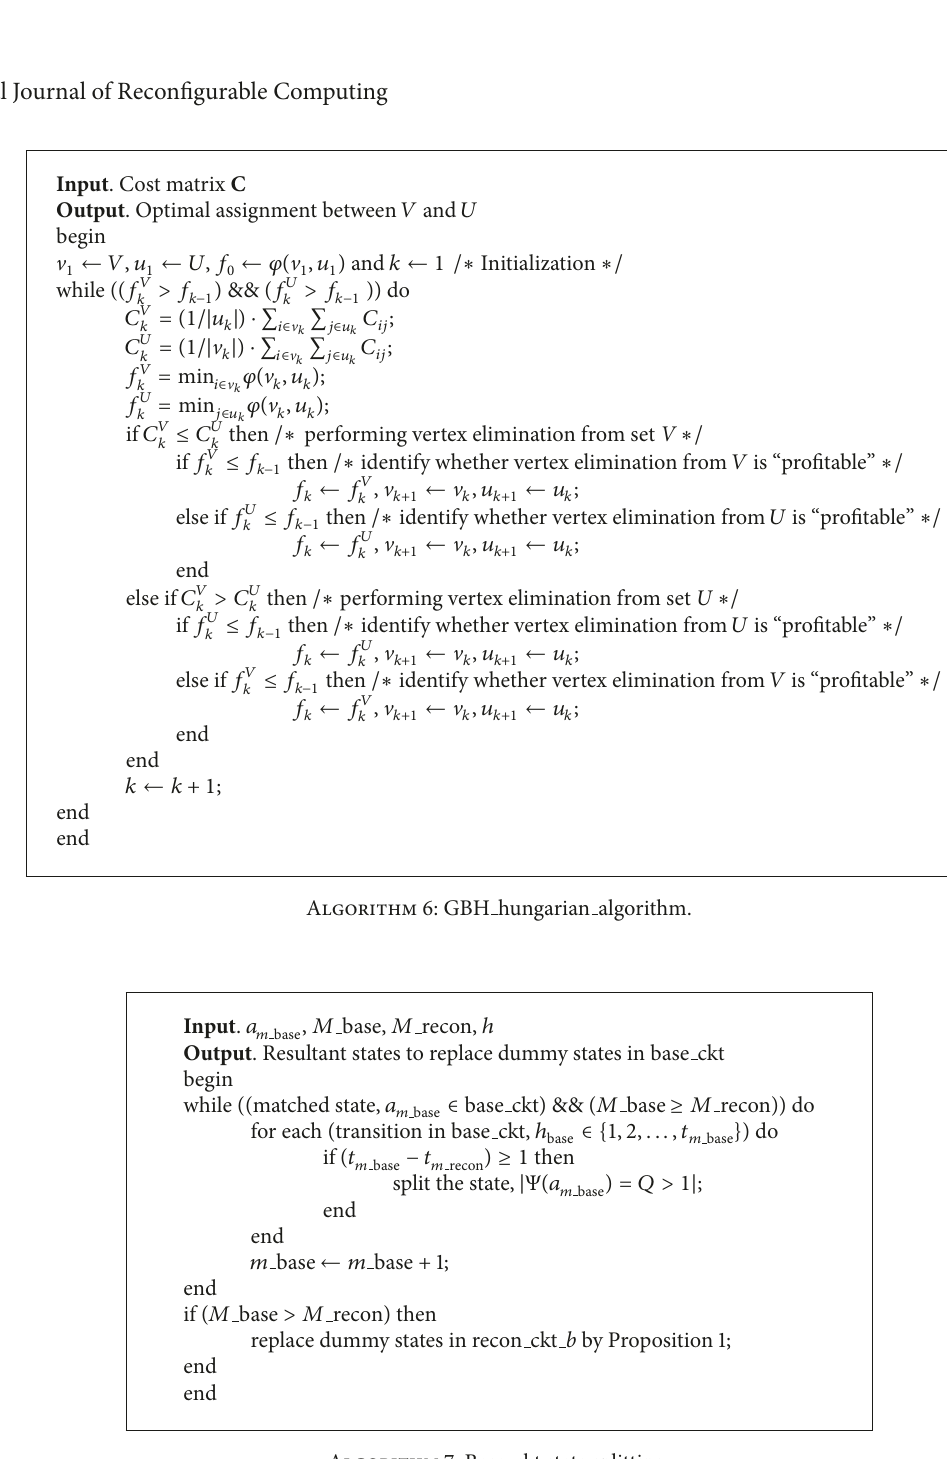
Algorithm 7: Base ckt state